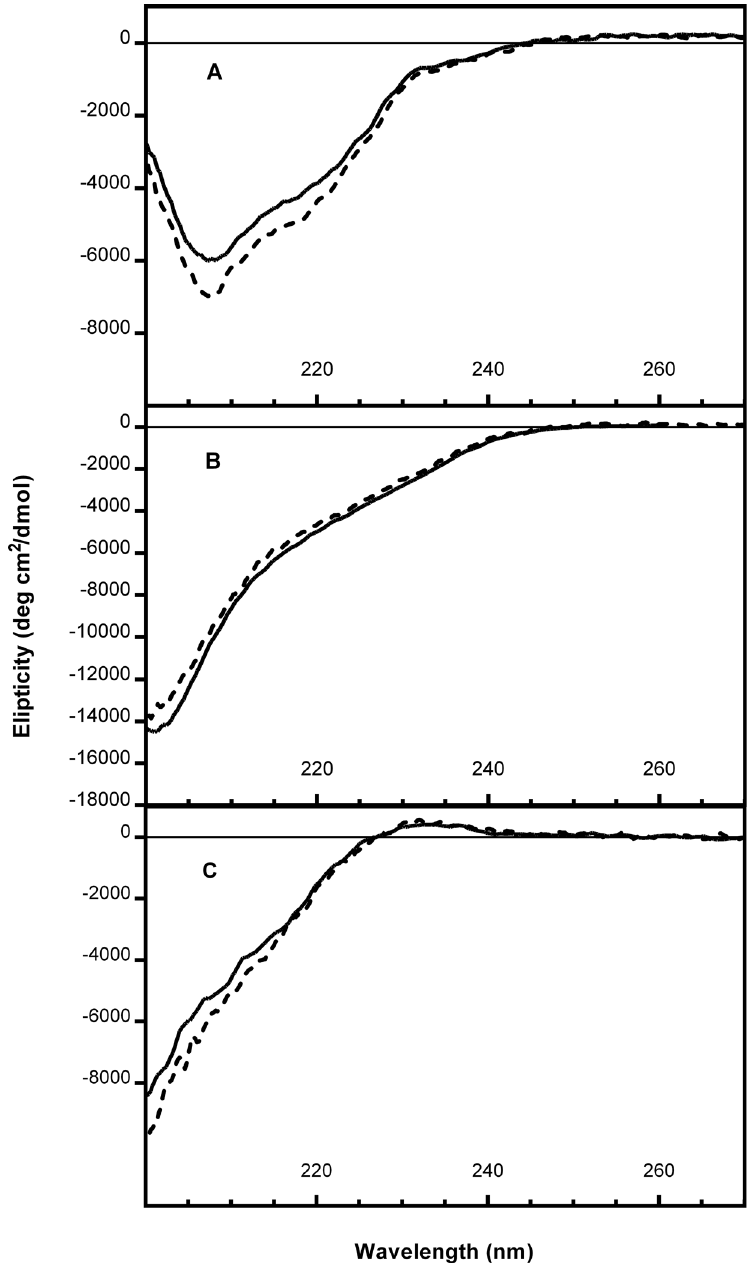
Fig 4. CD spectra of un-modified proteins and single component particles: A) 4.04 μ M AMA1 (solid line) and 4.04 μ M (AMA1 content) AMA1-AMA1 (broken line); B) 15.34 μ M CSPM3 (solid line) and 6.14 μ M (CSPM3 content) CSPM3-CSPM3 (broken line); C) 9.78 μ M Pfs25H (solid line) and 9.78 μ M (Pfs25H content) Pfs25H-Pfs25H (broken line). Stock solutions of proteins and particles in PBS were diluted with water to the stated concentrations. Spectra were obtained at